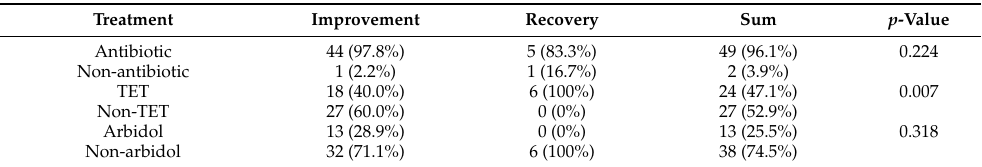
Table 3. Effect on outcome of treatment with antibiotic, tetrandrine, and arbidol of moderate COVID-19 patients ( n = 51).